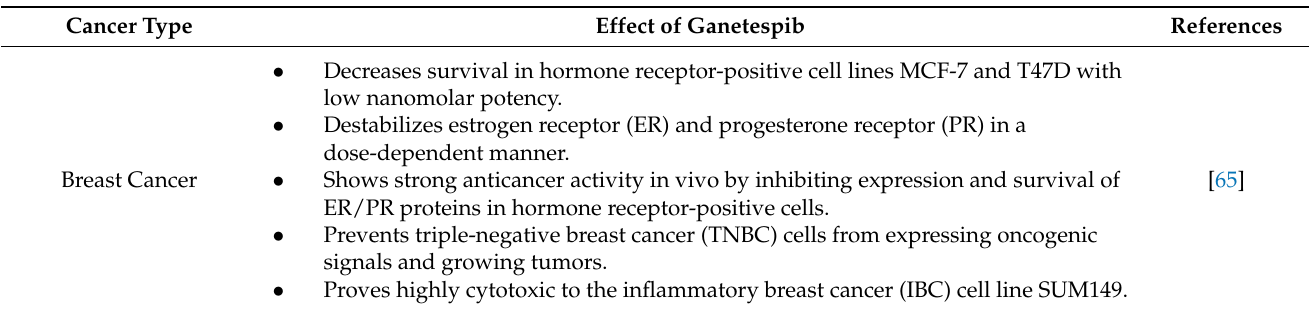
Table 3. Effect of ganetespib on different types of